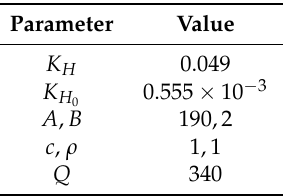
Table 1. Values of the parameters used in the numerical simulation. Based on those that are given in [8], but scaled to the rectangle [ − 1,1 ] × [ 0, − 1 ]